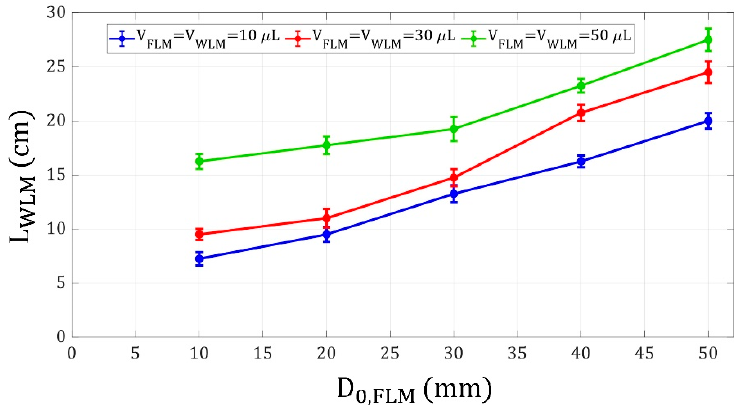
Figure 7. WLM shooting distance versus FLM initial distance from the electromagnet for liquid marble volumes of 10, 30, and 50 μ L, WLM initial distance of 0 mm from the electromagnet, and coil current of 3 A.